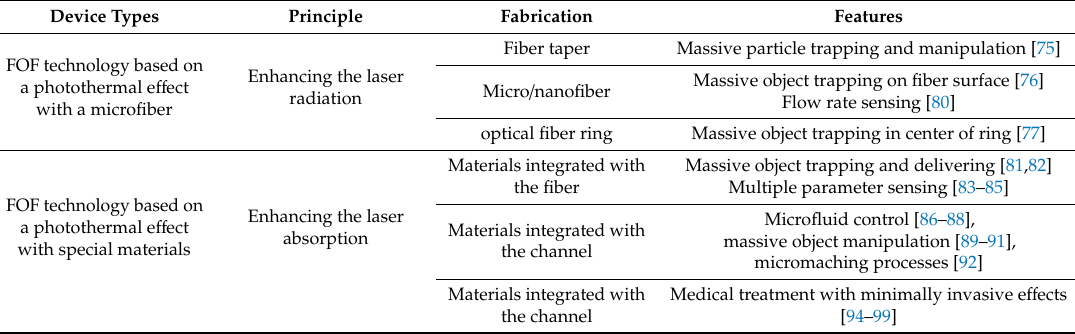
Table 3. A summary of fiber optofluidic technology based on a photothermal e ff